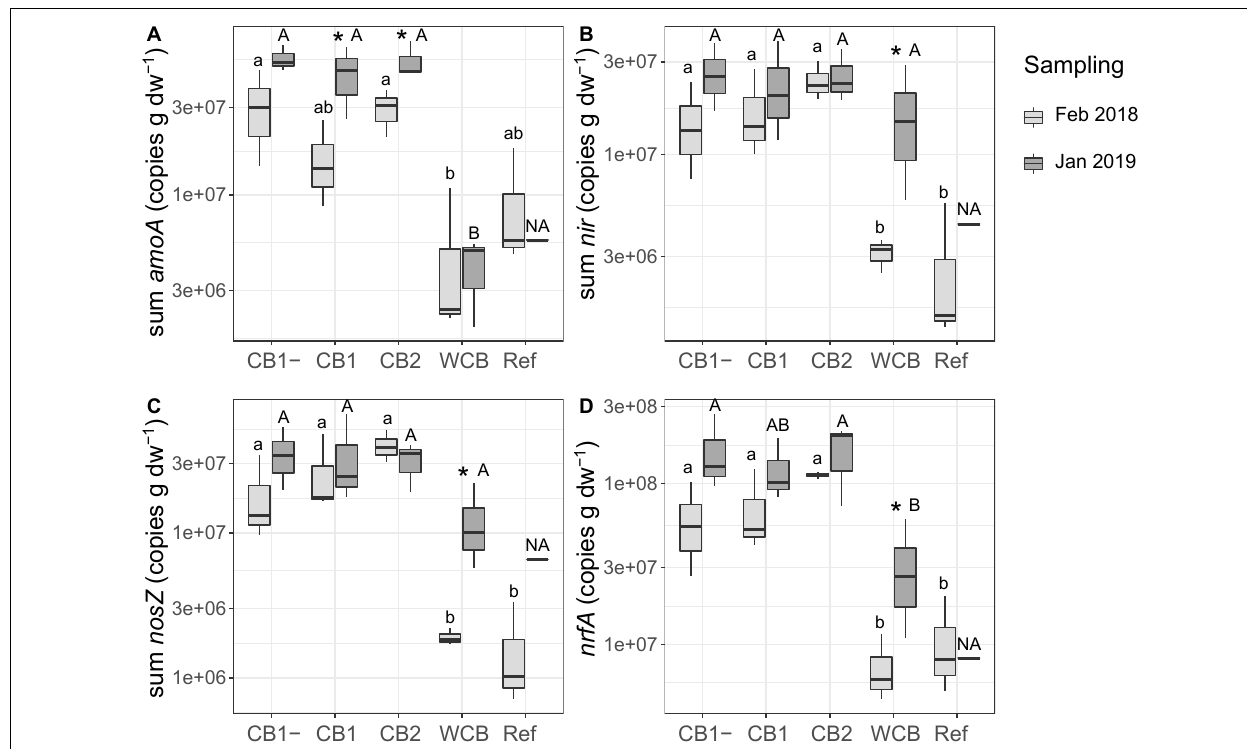
FIGURE 3 | Genetic potential for (A) ammonia oxidation, (B) denitrification, (C) nitrous oxide reduction, and (D) DNRA in the barrier materials and reference with top sand excluded across all depths based on the sum of functional groups for each process. Box limits represent the inter-quartile range with median values represented by the center line and whiskers represent values ≤ 1.5 times the upper and lower quartiles. For each barrier, stars denote if the mean values of the final abundances are significantly higher than the initial abundances (one-sided t -test, * p < 0.05, n = 3, reference final sampling n = 1). Different small letters above boxes indicate significant differences between barriers at the initial sampling and capital letters indicate differences at the final sampling occasion (Tukey’s HSD test, α = 0.05, and the final sampling in the reference is not included in the test, denoted